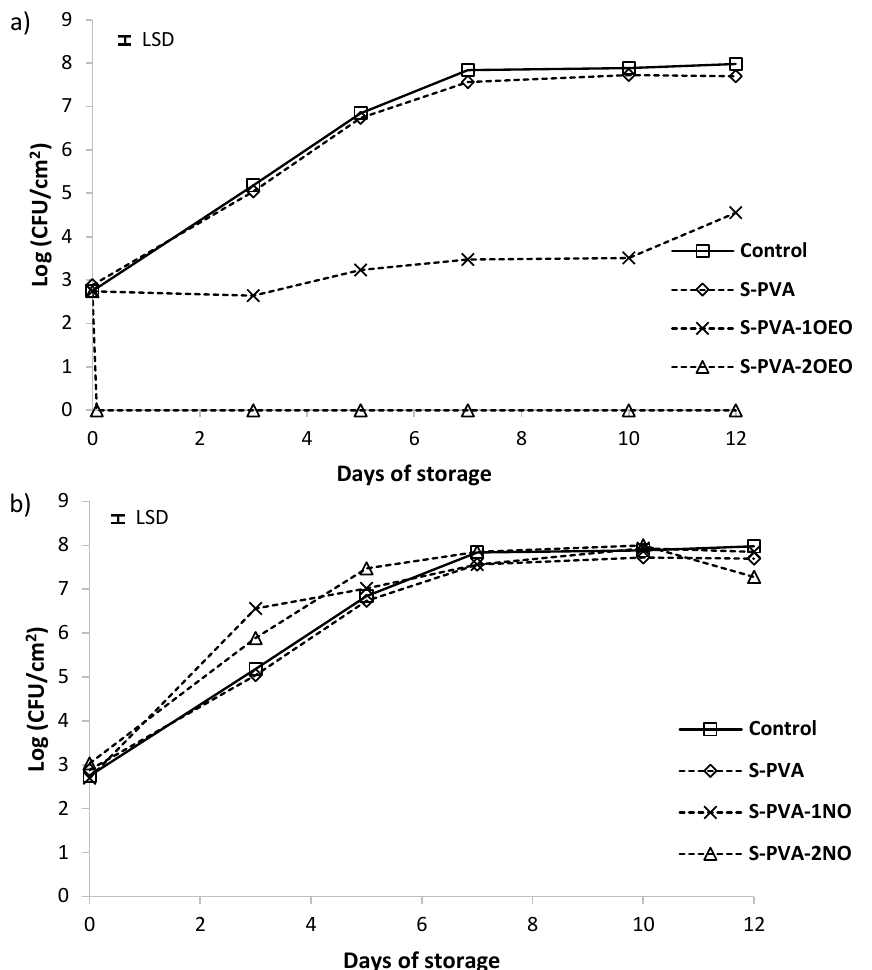
Figure 3. Population viability of Listeria innocua in TSA-NaCl medium at 10 °C ( a ) films with and without oregano essential oil (OEO) and ( b ) films with and without neem oil (NO). Mean values for each incubation period and 95% LSD interval are included in the plot. (LSD = ±0.05).